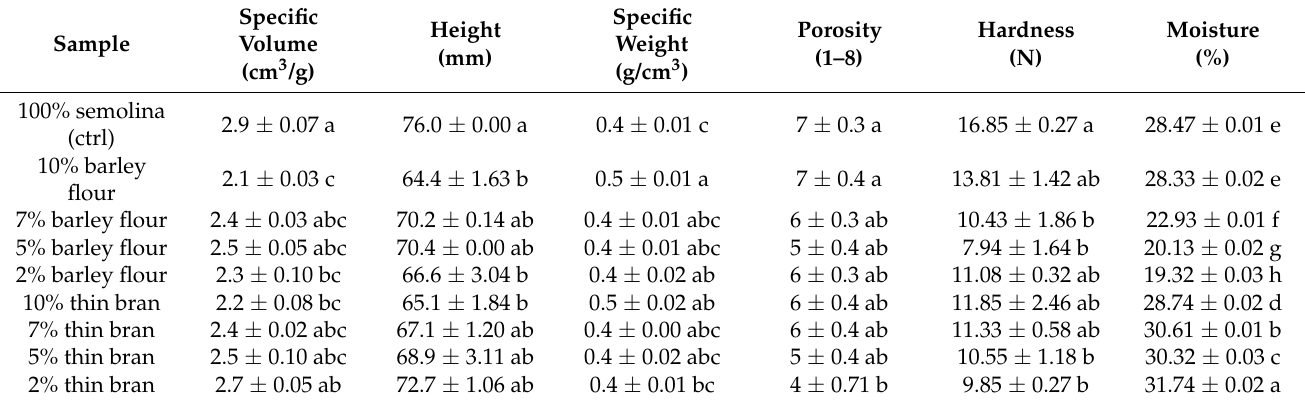
Table 7. Evaluation of physical properties and moisture of the bread samples produced using different types and levels of supplementation: one-factor ANOVA (analysis of variance) (data are means ± standard deviations).